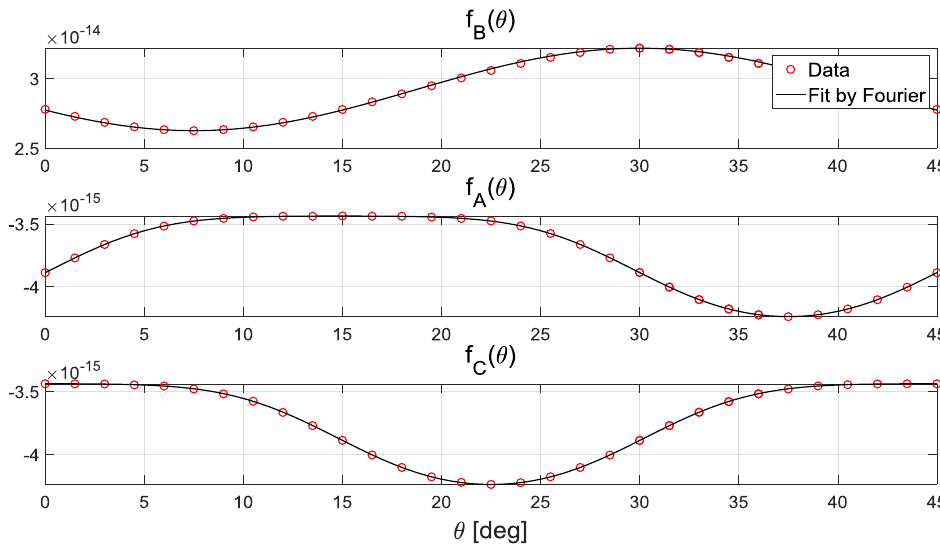
Figure 12. The amount of electric charges on the rotor when the three-phase voltage is supplied with a fixed voltage.